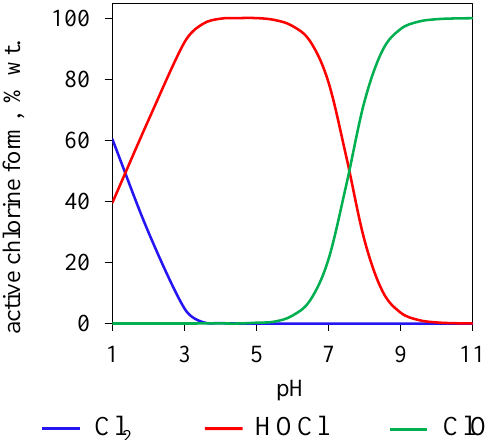
Figure 1. Curves of equilibrium concentrations of elemental chlorine (Cl 2 ), chloric acid (HOCl), and (ClO- chlorate (I) ions ) in aqueous solutions depending on the pH.